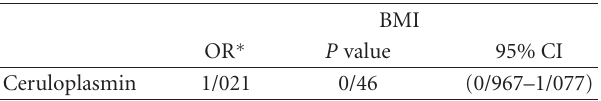
Table 2: BMI in relation to serum ceruloplasmin level. Results for logistic regression